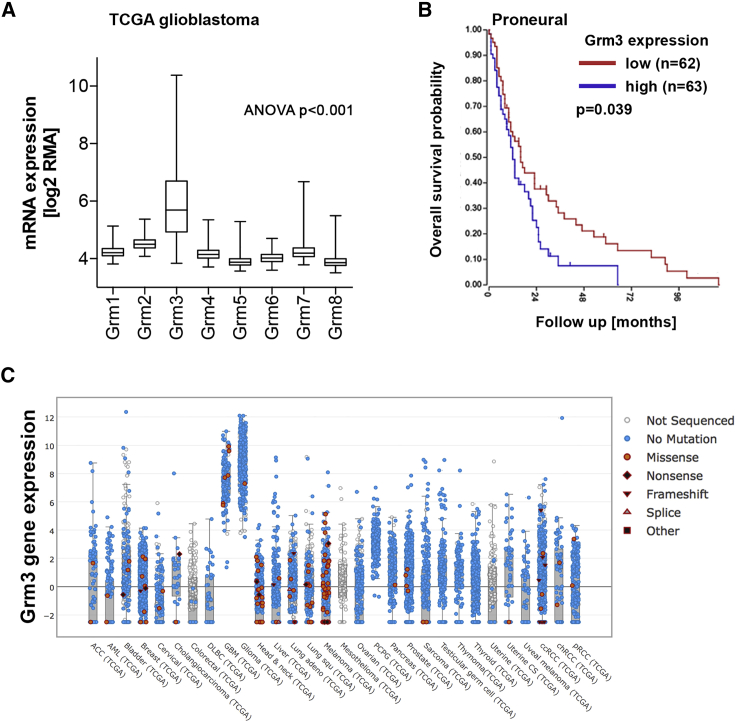
Gene expression of metabotropic glutamate receptors in glioblastoma(A) Grm1–Grm8 expression levels in glioblastoma samples (n = 539) from The Cancer Genome Atlas (TCGA) were accessed through the Xena Functional Genomics Explorer: https://xena.ucsc.edu.11 The box indicates mean and SEM, whiskers represent the range. (B) Kaplan-Meier curve of patients with proneural glioblastoma stratified by GRM3 gene expression levels (cutoff: median GRM3 gene expression). (C) Cross-cancer study of GRM3 mutational status determined by next-generation sequencing and GRM3 gene expression. Data from TCGA were accessed through the cBIO portal: www.cbioportal.org.12